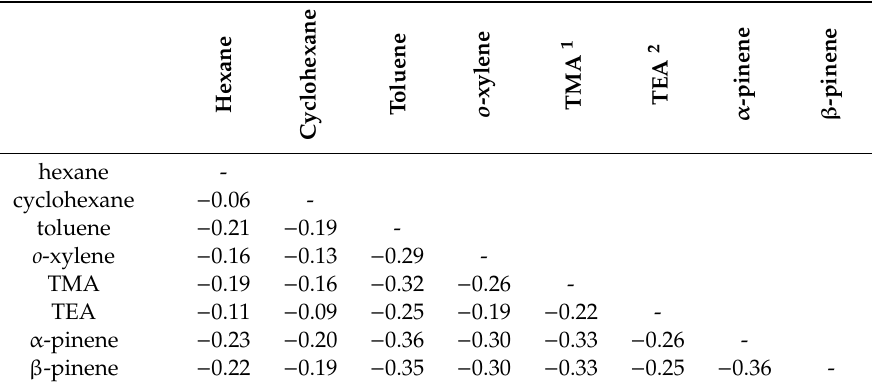
Table 8. UPL model odor interaction coe ffi cients.